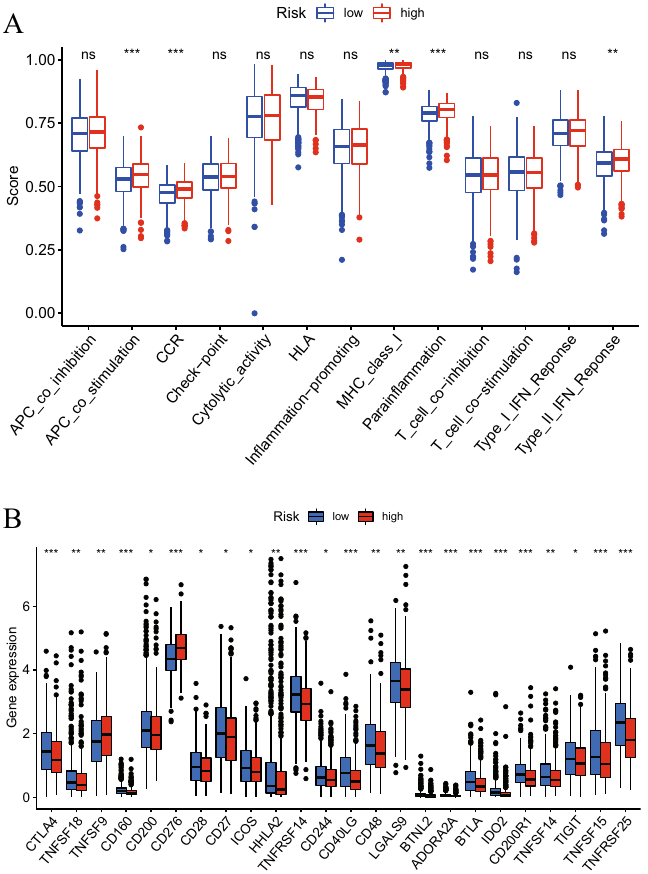
Figure 8. ( A ) ssGSEA scores of 13 immune-related functions in high- and low-risk patients. ( B ) Expression levels of 24 immune checkpoints in high- and low-risk patients. *P < 0.05, **P < 0.01, ***P <